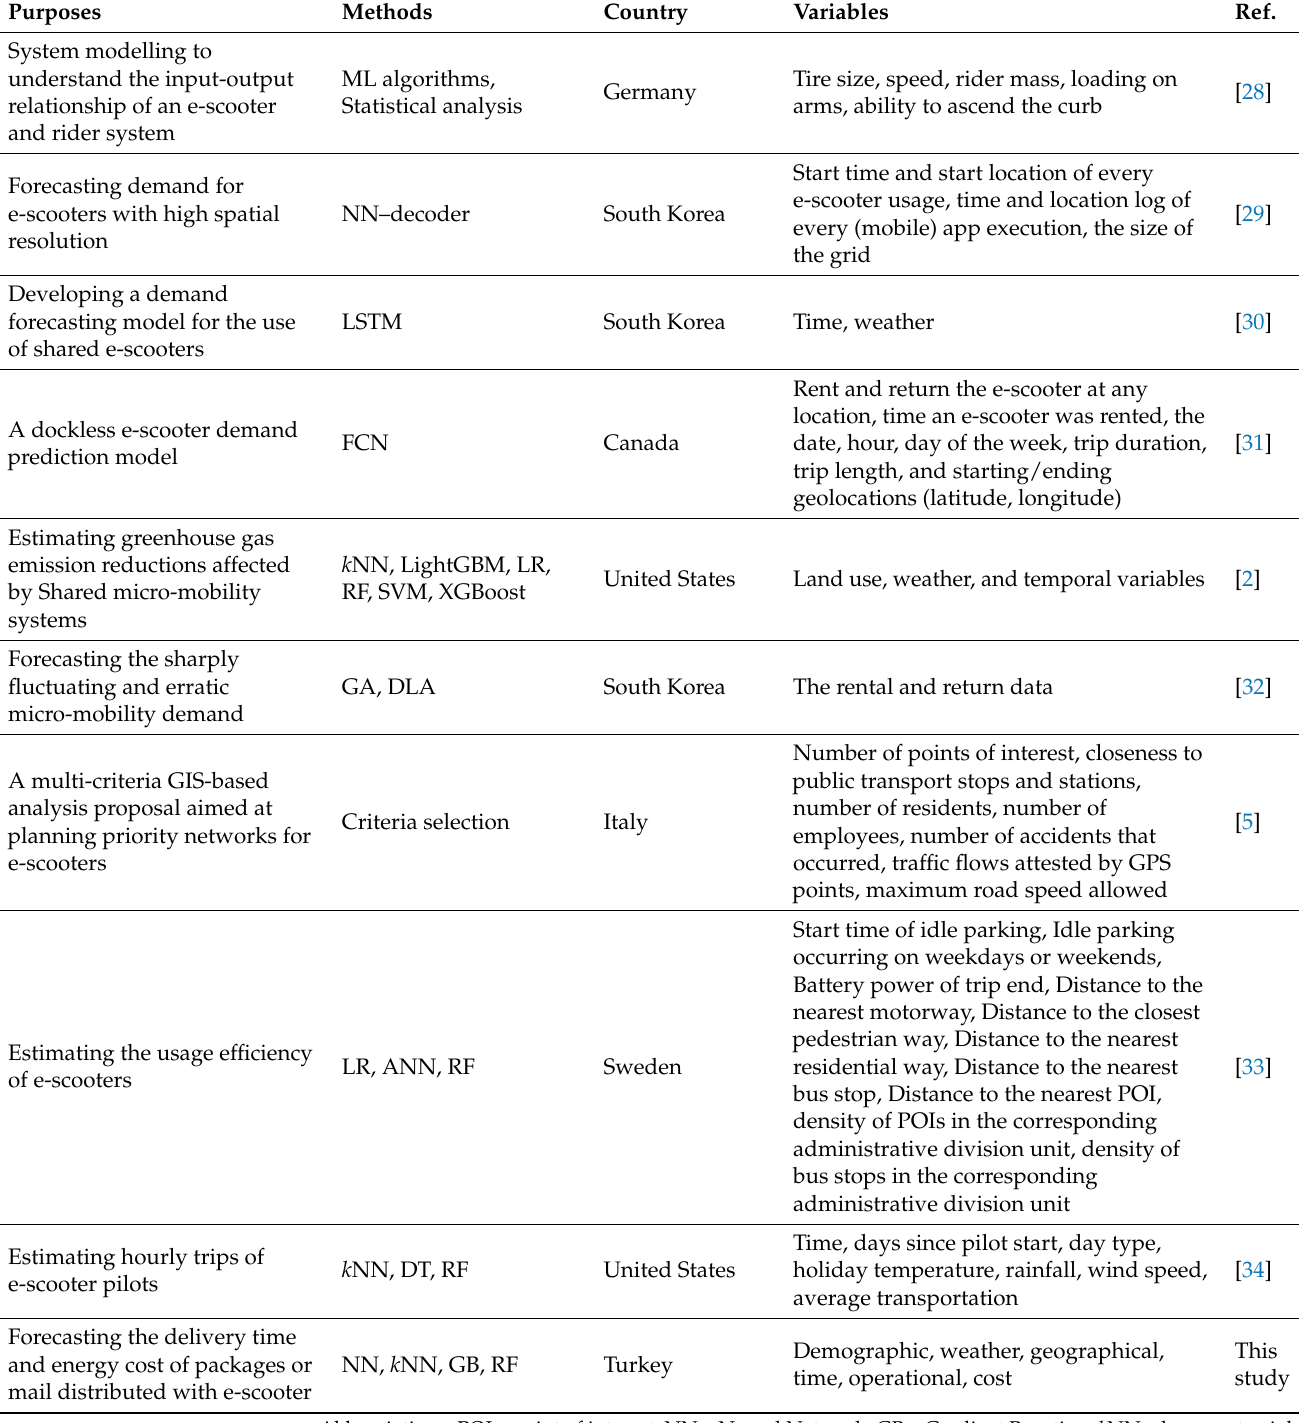
Table 1. Features of selected studies related to this